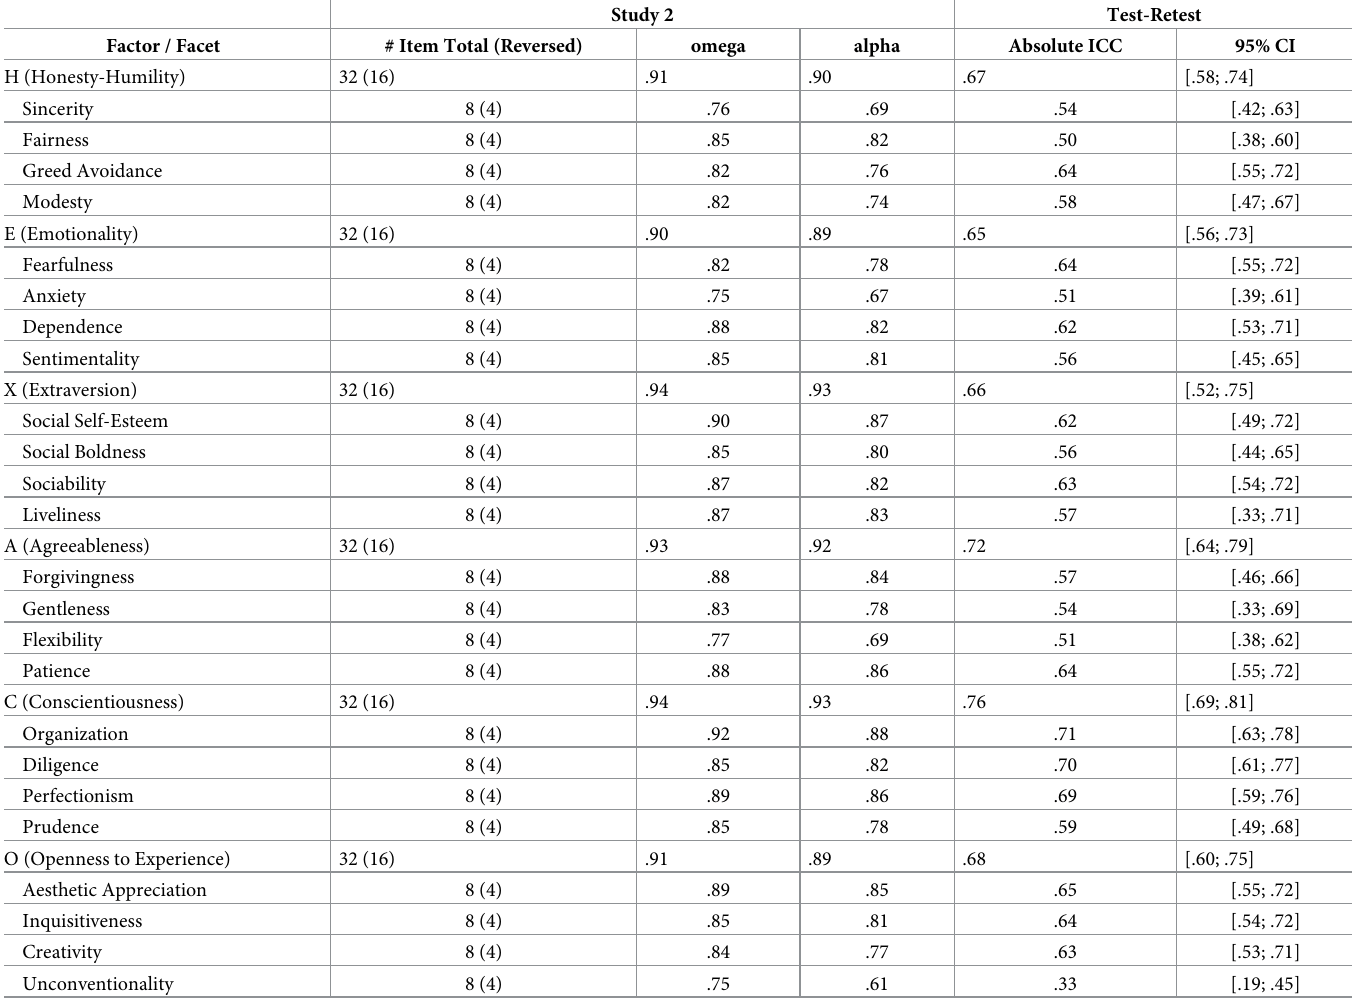
Table 6. Reliability coefficients of the 192-item HEXACO-MSI-E (Study 2) and stability indexes with 95% CI for the test-retest study (Study 1 and